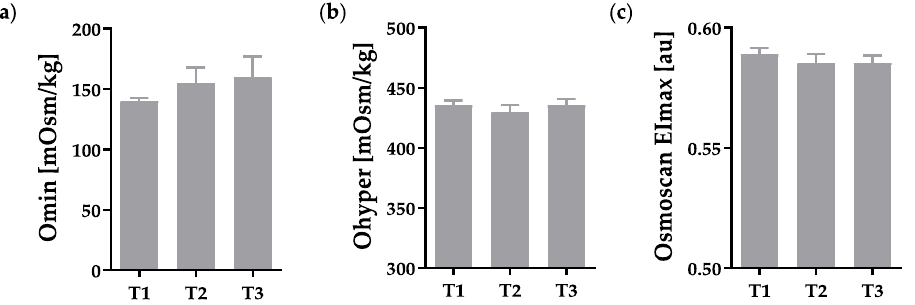
Figure 2. Deformability parameters under an osmotic gradient measured by Osmoscan, indicating no changes due to hypoxia with unaffected ( a ) O min , ( b ) O hyper , and ( c ) EI max . Datasets included in this figure: ( a ‐ c ) T1: n = 14, T2: n = 11, T3: n = 8. Staining intensity of RBC ‐ NOS serine 1177 phosphorylation (Figure 3a) and RBC ni ‐ trite/RSNO/Fe ‐ NO concentration (Figure 3b) remained unaffected by hypoxia exposure.